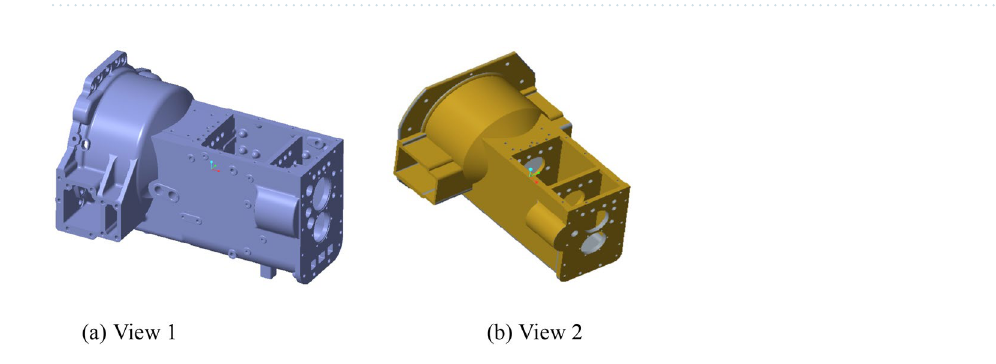
Figure 2. Transmission assembly diagram.